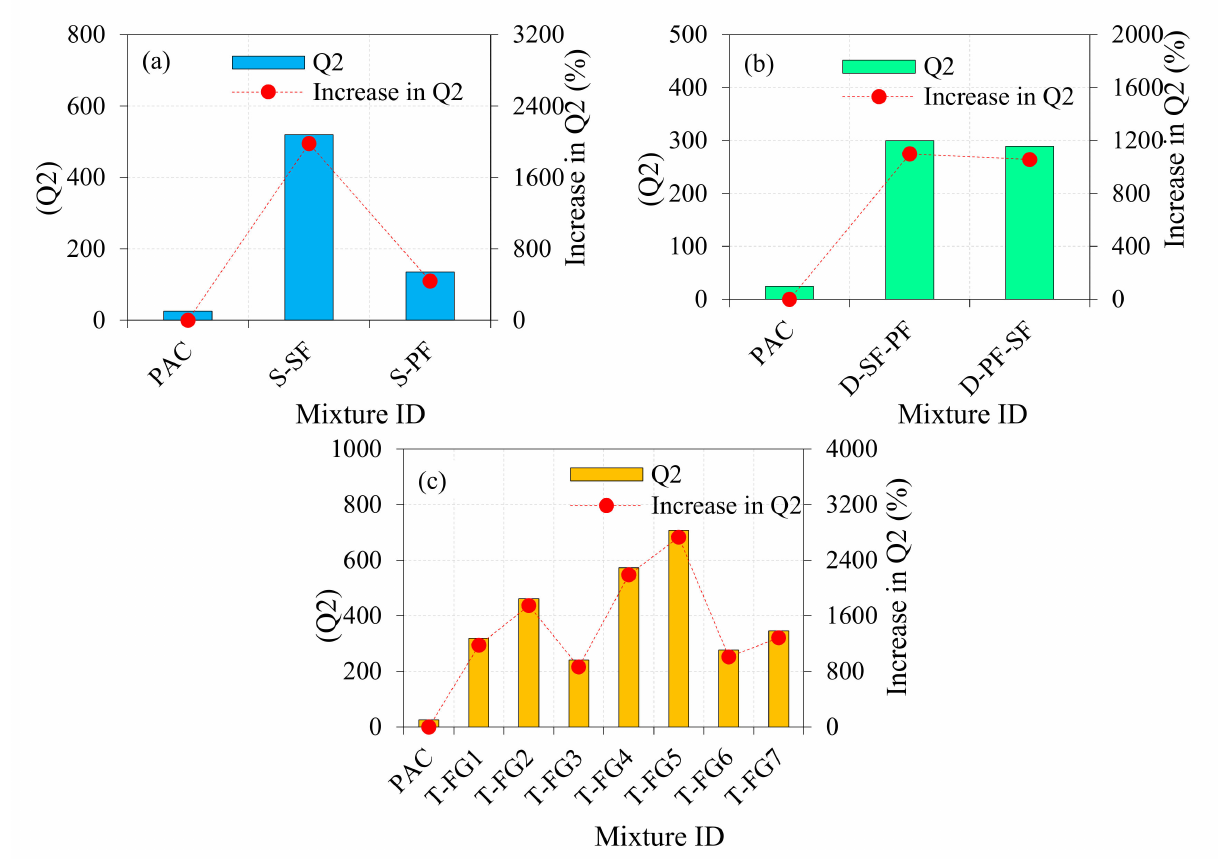
Figure 11. Failure impact number (Q2) of the modified impact test: ( a ) single-layer specimens, ( b ) double-layer specimens, ( c ) triple-layer